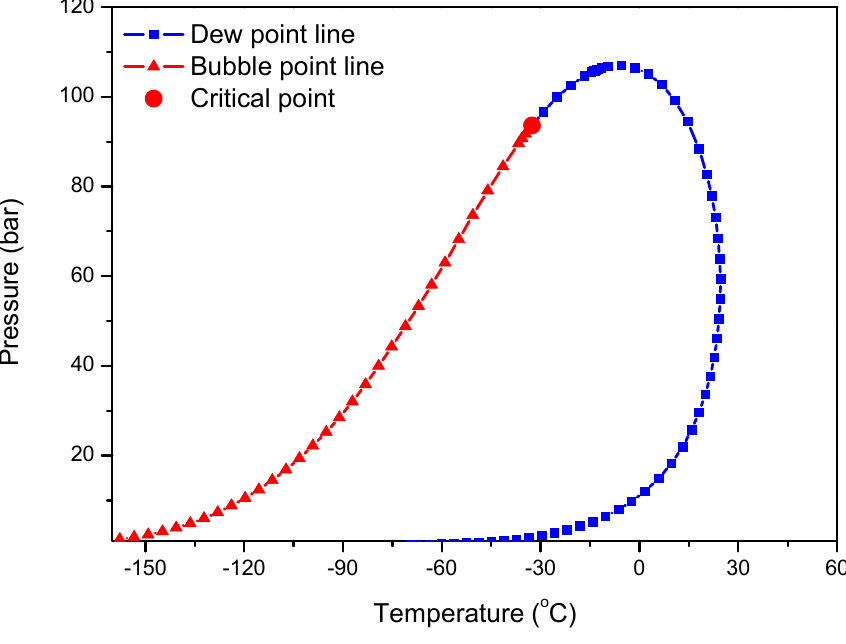
Figure 2. Phase envelope of natural gas.